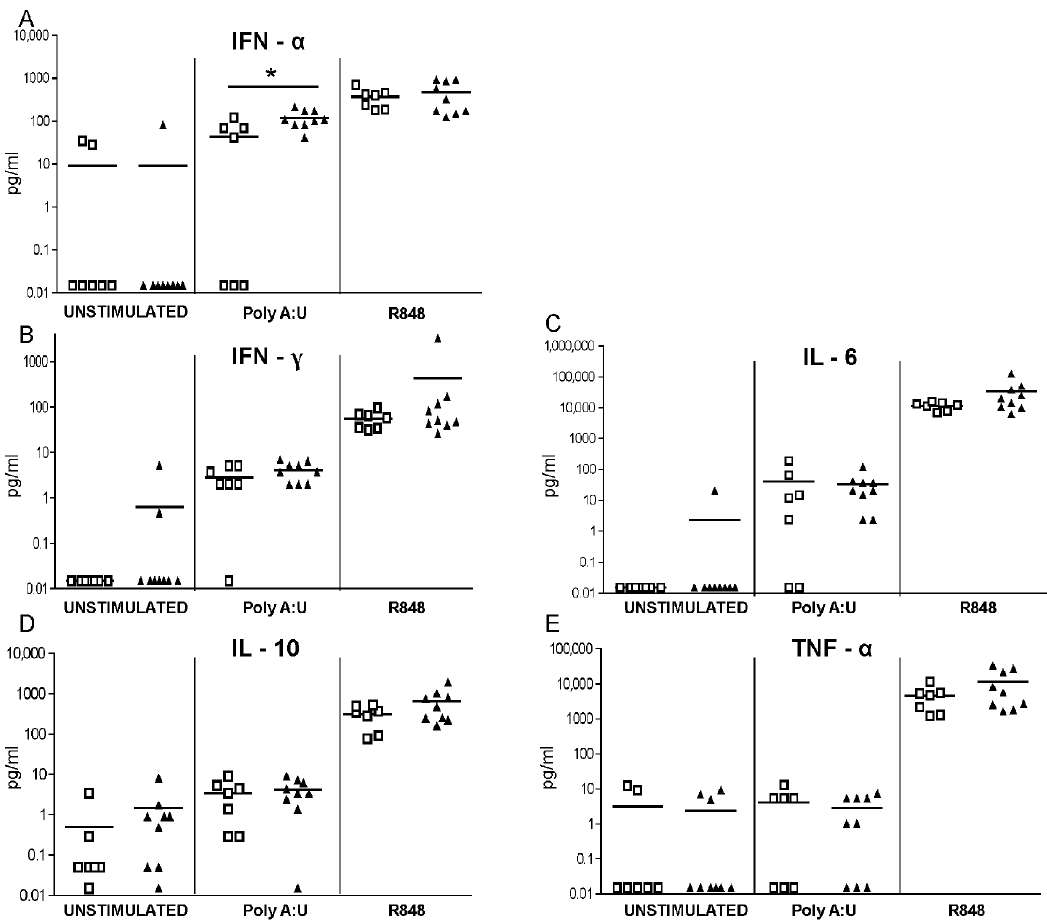
Figure 3. TLR-induced cytokine responses in blood cells from TOSV-infected patients and healthy controls. Blood cells were left unstimulated or stimulated with poly(A:U) (TLR3 ligand; 20 µg/mL) or Resiquimod-R848 (TLR7/8 ligand; 10 µg/mL). After 24 h, supernatants were collected and analyzed for cytokine levels. White squares indicate healthy controls and black triangles indicate TOSV-infected patients. N = 8 TOSV-infected patients and n = 7 healthy controls were evaluated. Data were analyzed using the non-parametric Mann–Whitney U test. * indicates p ≤ 0.05.